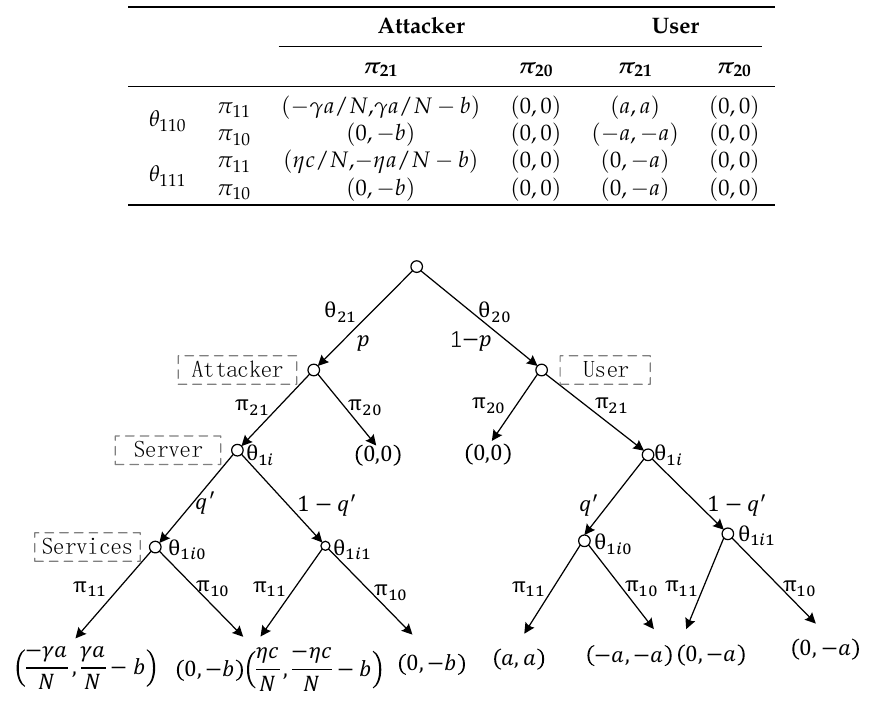
Figure 4. Attack-defense game